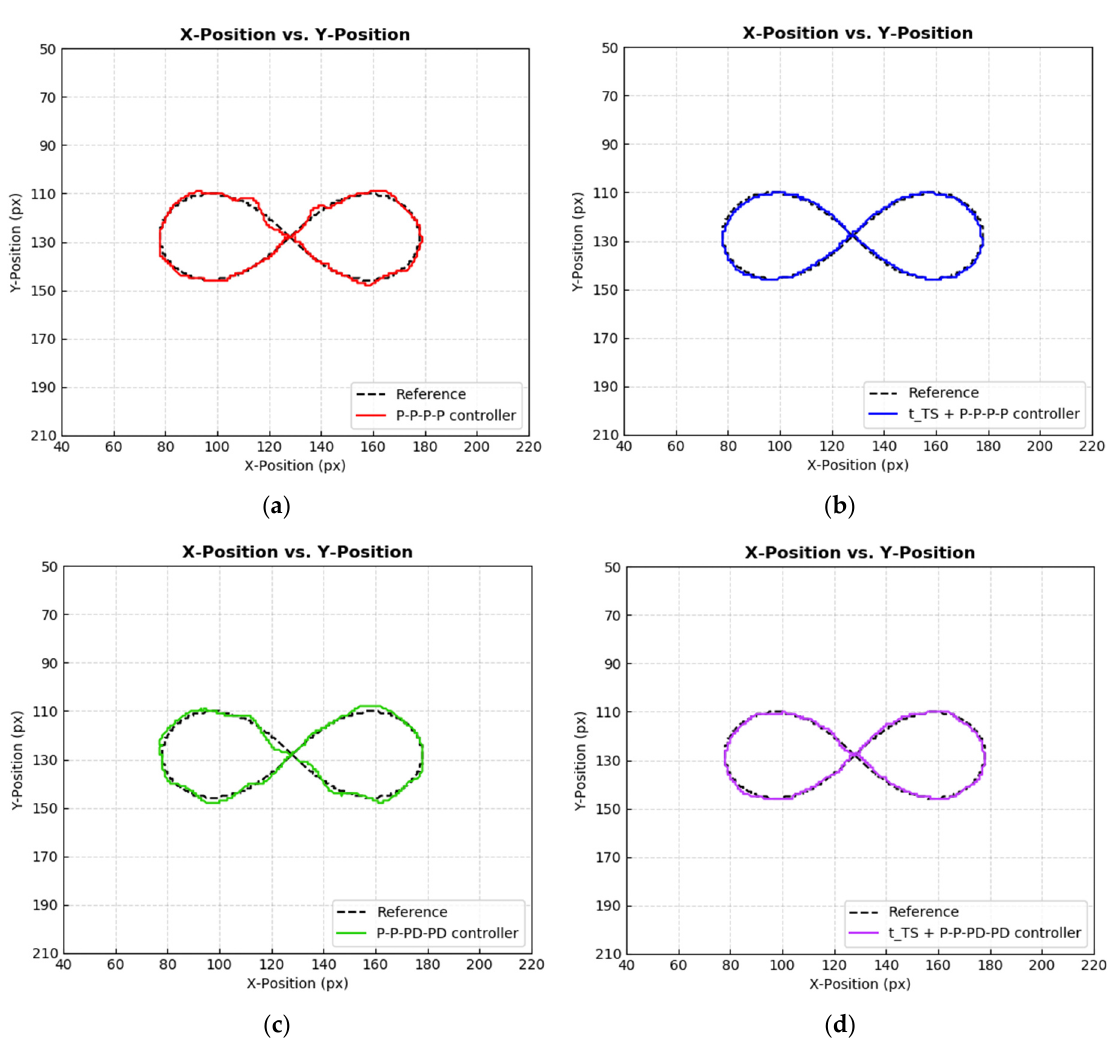
Figure 19. ∞ -shaped trajectory tracking performance by ( a ) P–P–P–P controller, ( b ) t TS + P–P–P–P controller, ( c ) P–P–PD–PD controller, and ( d ) t TS + P–P–PD–PD controller on Cartesian Table 3. IAEs and ISEs by each controller in tracking of ∞ -shaped trajectory.